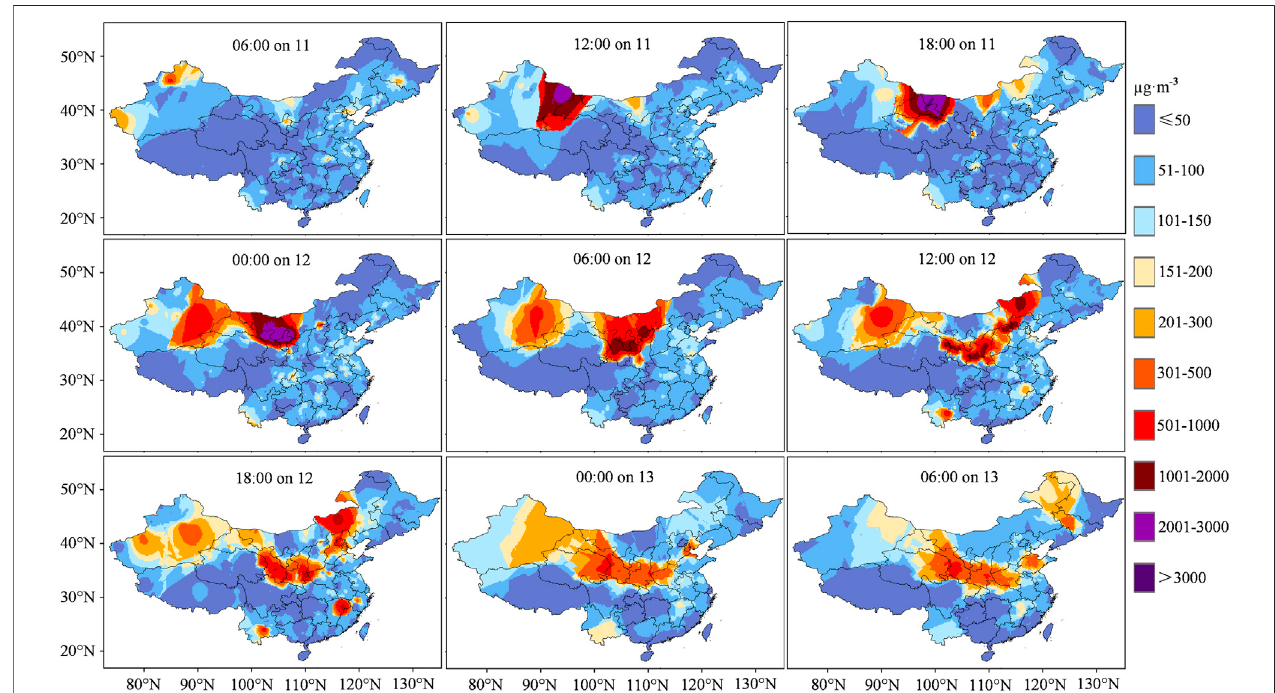
FIGURE 2 | Distribution of the hourly concentration of PM 10 monitored on the ground from 06:00 on 11 May to 06:00 on 13 May.